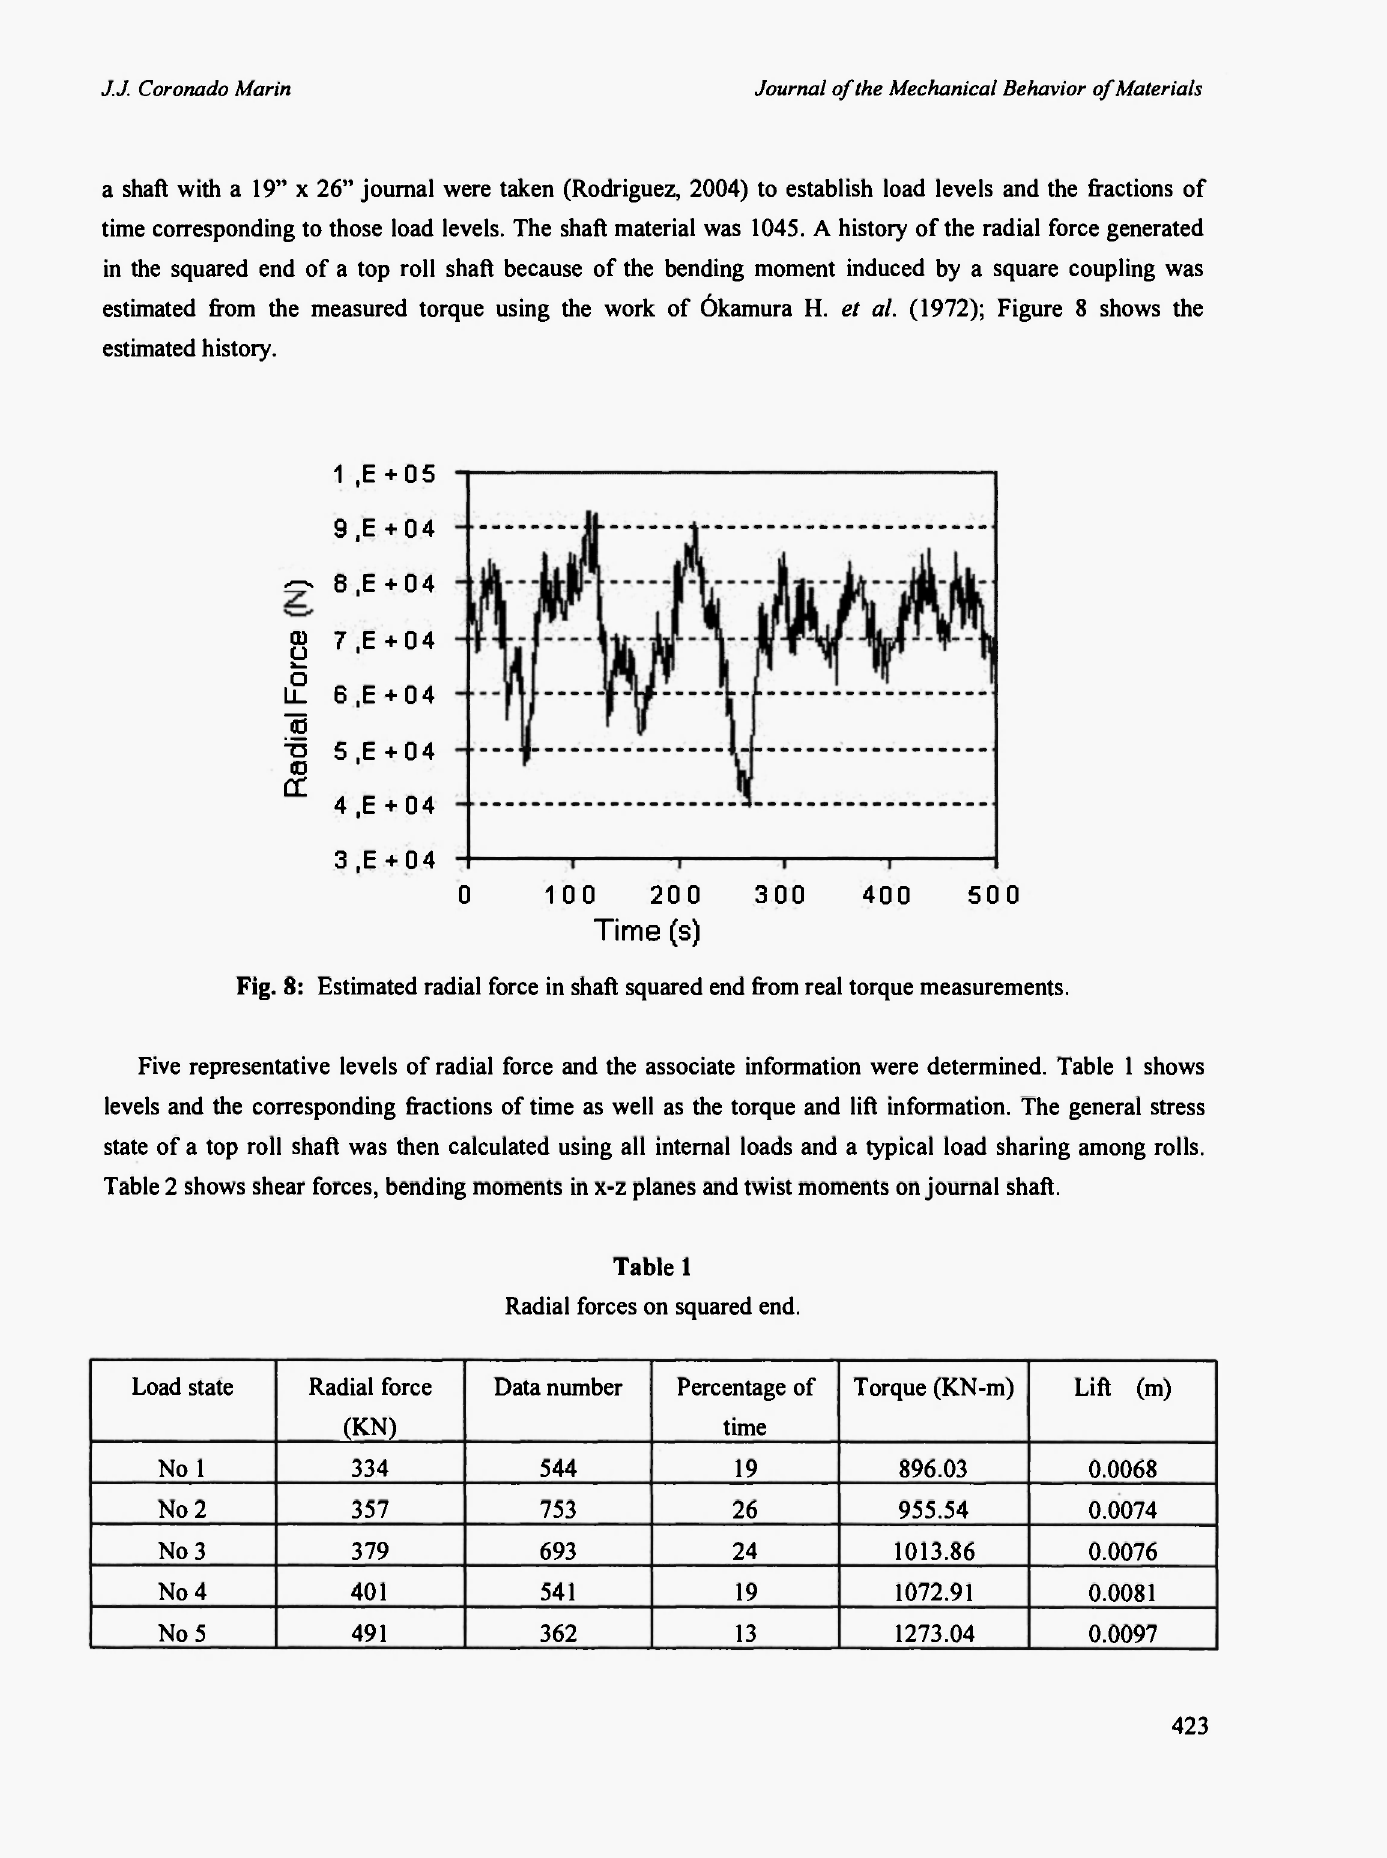
Radial forces on squared